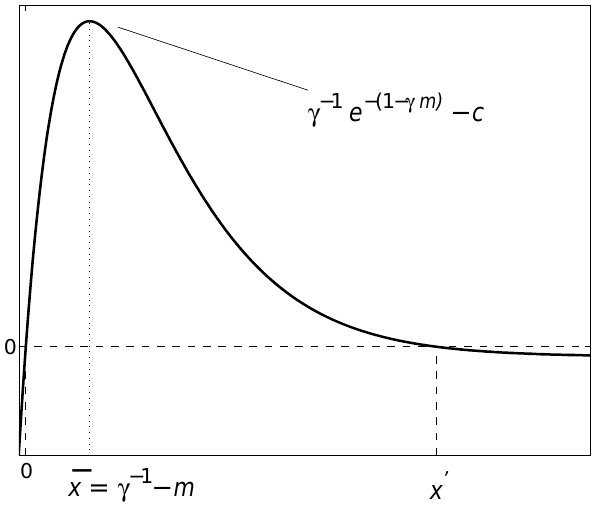
Fig. A1. Backscatter retrieval function, f (x) , for c = m , see Eq. (A1). The dotted line corresponds to the function maximum at ¯ x = γ − 1 − m with function value γ − 1 exp [− ( 1 − γm) ]− c . The dashed lines correspond to the two solutions x = { 0 ,x